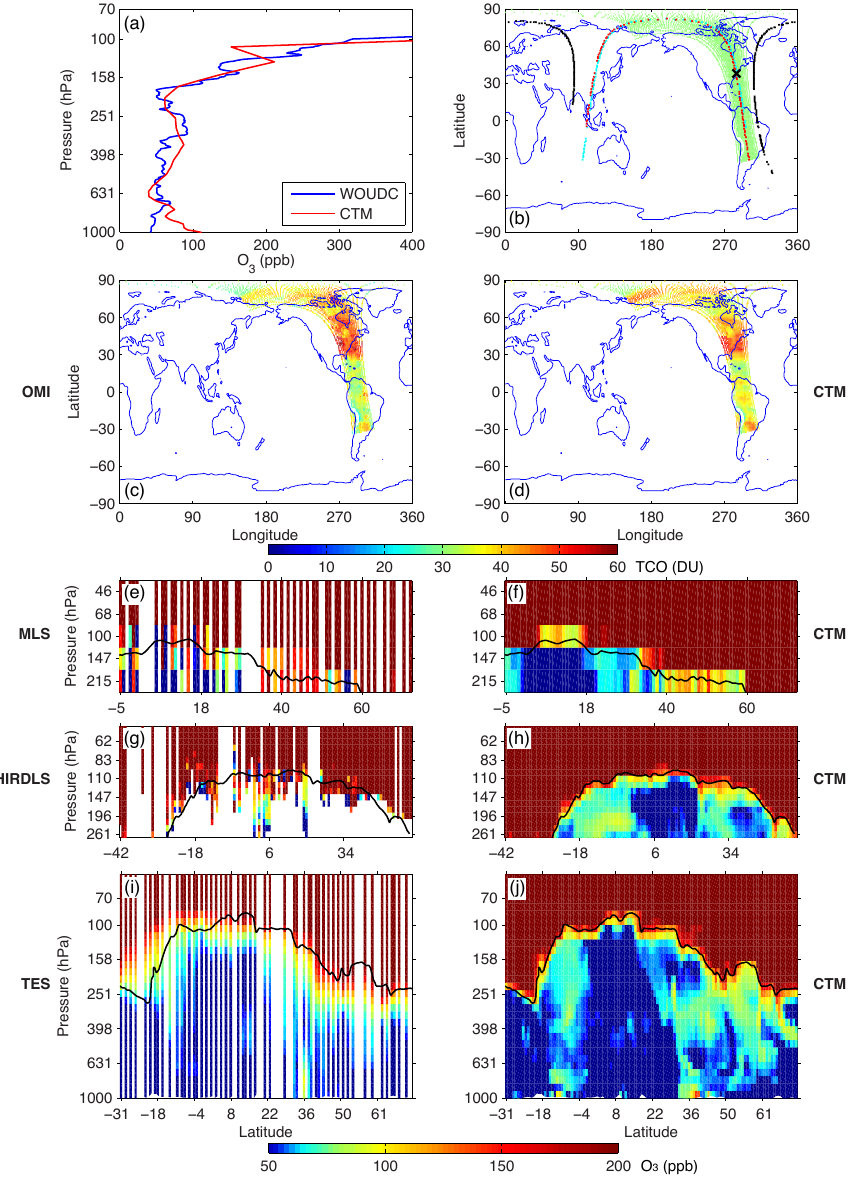
Fig. 4. Same as Fig. 3 for 25 August 2005. The sonde is from Wallops Island (37.9 ◦ N, 75.5 ◦ W, station code 107) at 17:39UTC, compared with model simulation at 18:00UTC in (a) . The Aura and CTM swaths are for 18:00–19:00UTC. (c) – (j) show the swaths in 180 ◦ E–360 ◦